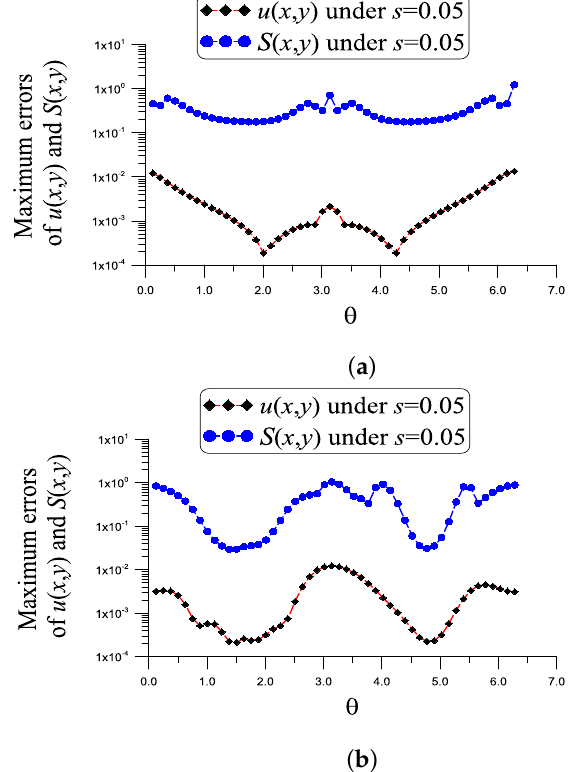
Figure 7. Showing the errors in the numerical recovery of u and S under a noise s = 0.05, ( a ) example 6 and ( b ) example 7.